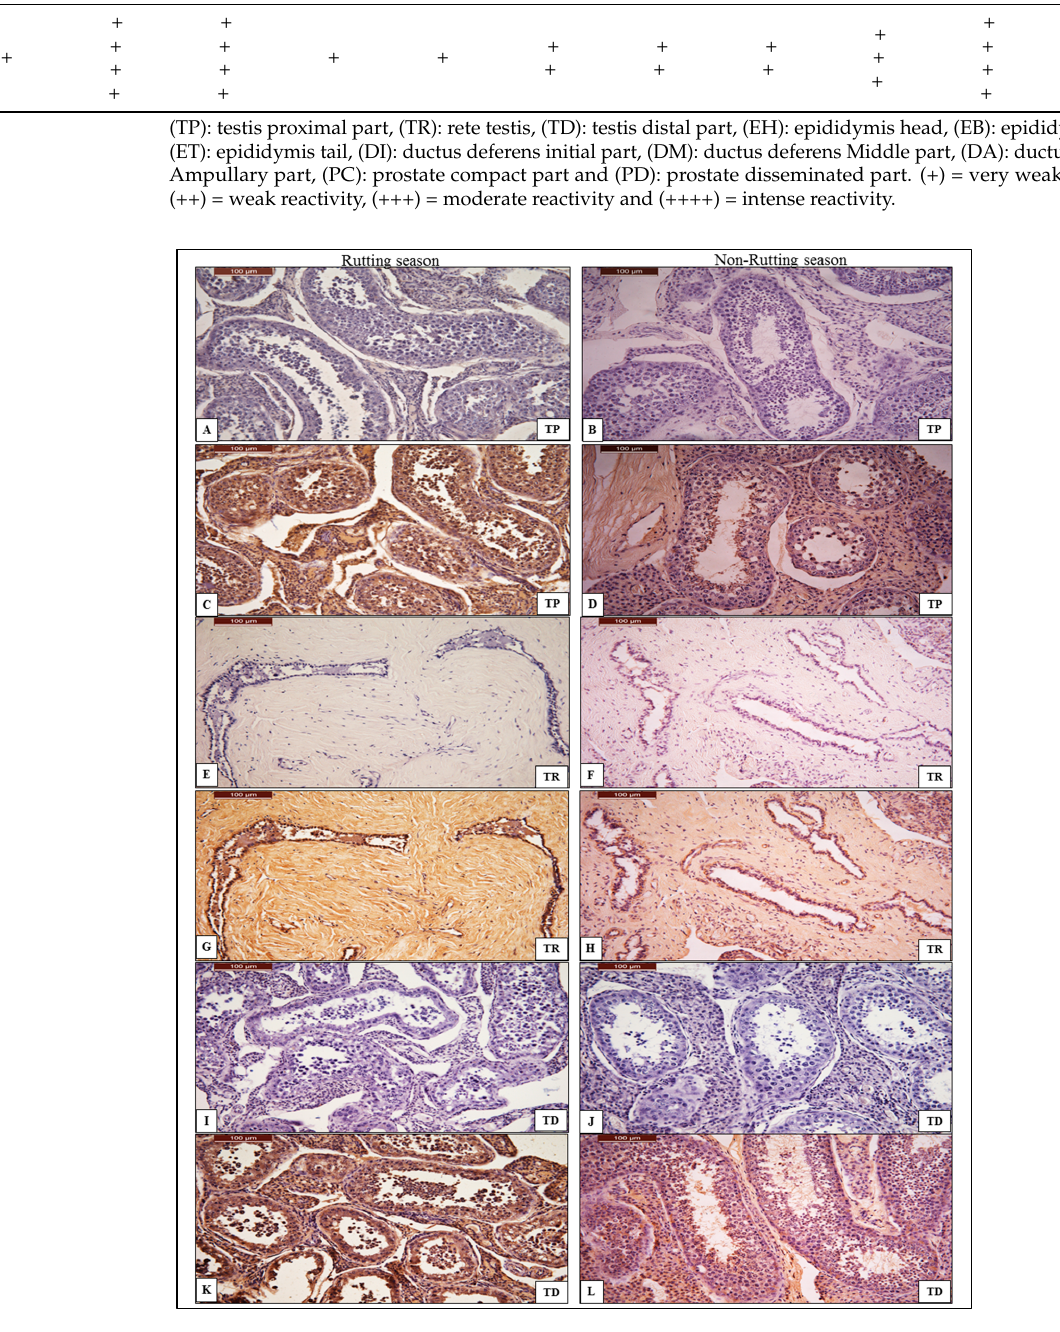
Figure 2. Chromogenic immunohistochemistry of anti-AQP-7 antibody in the proximal part (TP), rete testis (TR) and distal part (TD) of the testes. ( A , E , I ): negative control of anti-AQP-7 antibody in TP, TR and TD during rutting season. ( C , G , K ): positive reactions of AQP-7 in TP, TR and TD of the testes show immunohistochemical detection of AQP-7 localized in seminiferous tubules with normal spermatogenesis during rutting season. ( B , F , J ): negative control of AQP-7 in TP, TR and TD of the testes during non-rutting season. ( D , H , L ): weak positive reaction of AQP-7 in TP, TR and TD of the testes during non-rutting season shows immunohistochemical detection of AQP-7 localized in the sperm head. AQP-7 is stained by DAB/chromogen and counter-stained with hematoxylin under magnification power 40×.